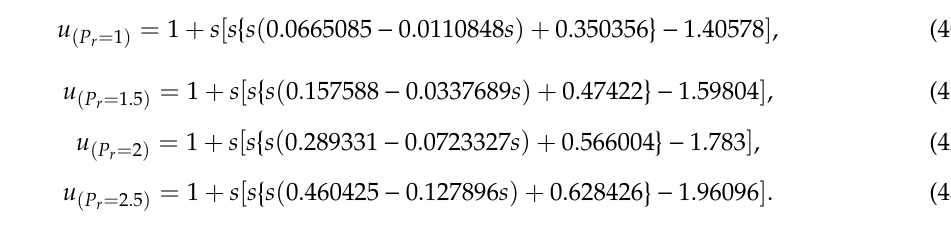
Figure 5. λ at different values of 𝑃 (cid:3045) and 𝑠 . ( a ) with the s range of [0–2]; ( b ) with the s range of [0–3]; Figure 5. λ at di ff erent values of P r and s . ( a ) with the s range of [0–2]; ( b ) with the s range of [0–3]; ( c ) with the s range of [0–7]; ( d ) with the s range of [0–12].